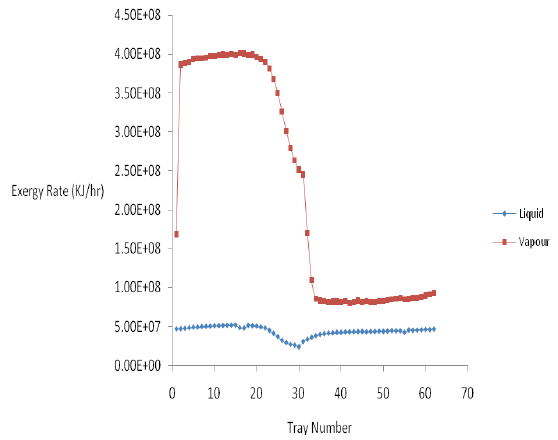
Figure 26. Profile of exergy rate versus tray number for Debutanizer of base 1200KPa Case